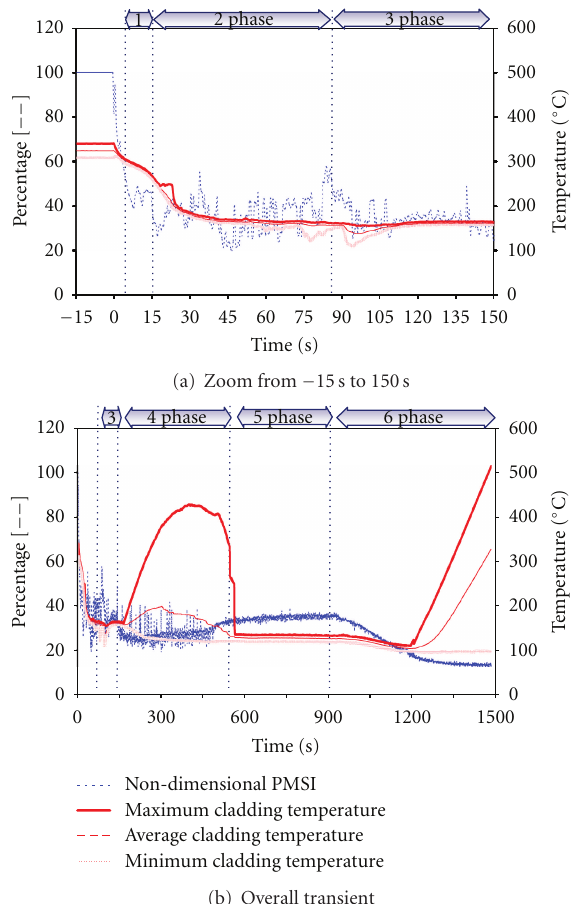
Figure 3: OECD/NEA experiment PSB-VVER CL-2x100-01: non- dimensional trend of primary side mass inventory (PMSI); upper and lower envelops and average value of all cladding temperatures